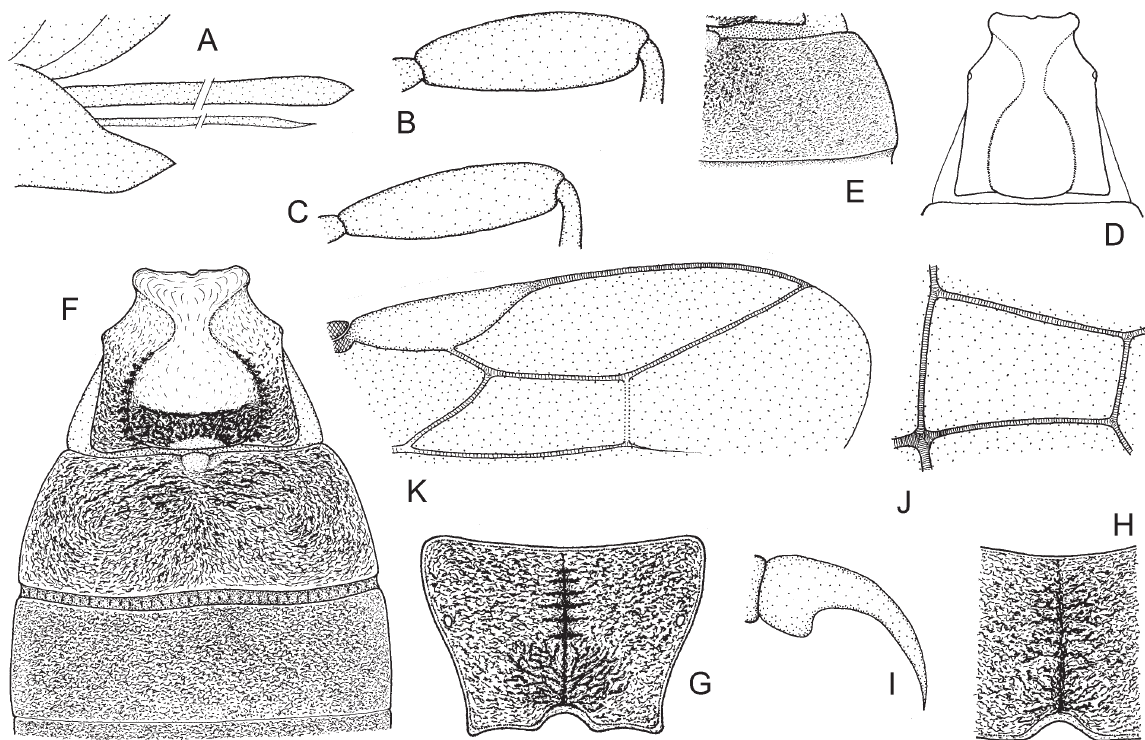
Fig. 61. — A-E . Bracon ( Bracon ) fulvipes Nees, 1834 (A: ♀ neotype, B-C, E: ♀, D: ♀ / ♂). A . Hind end of metasoma. B-C . Hind femur. D . First tergite. E . Right half of second tergite. — F-K . Bracon ( Bracon ) schmidti Kokujev, 1912, ♀ lectotype. F . Tergites 1-3. G . Propodeum. H . Middle part of propodeum. I . Claw. J . First discal cell of right forewing. K . Distal part of right